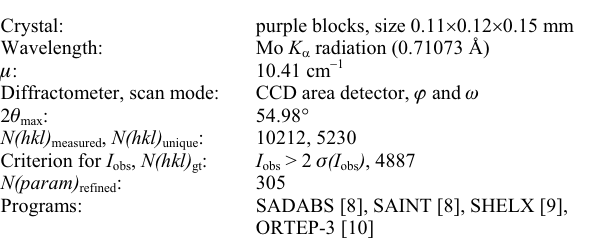
Table 1. Data collection and handling.